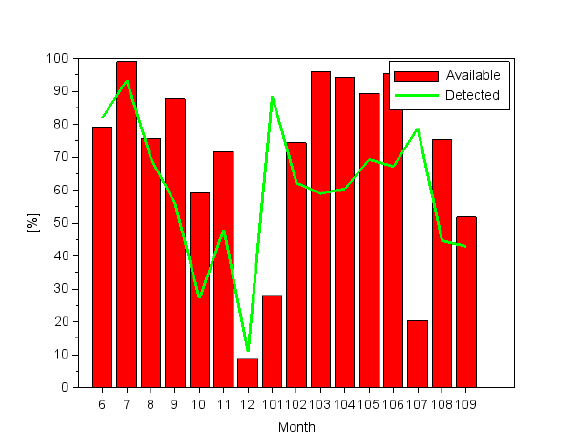
Figure 2. The frequency of detection for individual months in years 2010 and 2011 depending on the number of available data (dates) – green line. The columns present the percentage of